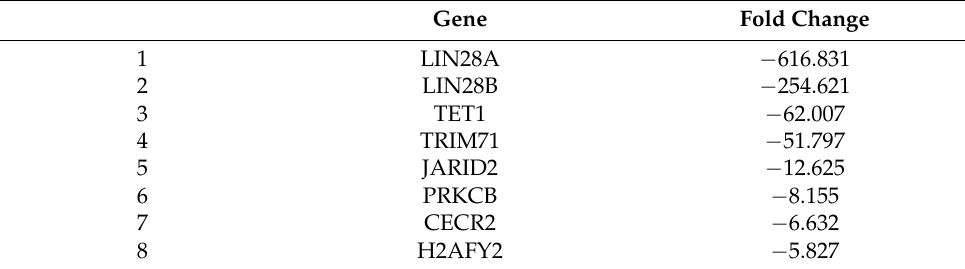
Table 10. Genes in epigenetic category that are downregulated in endothelial cells. Gene Fold